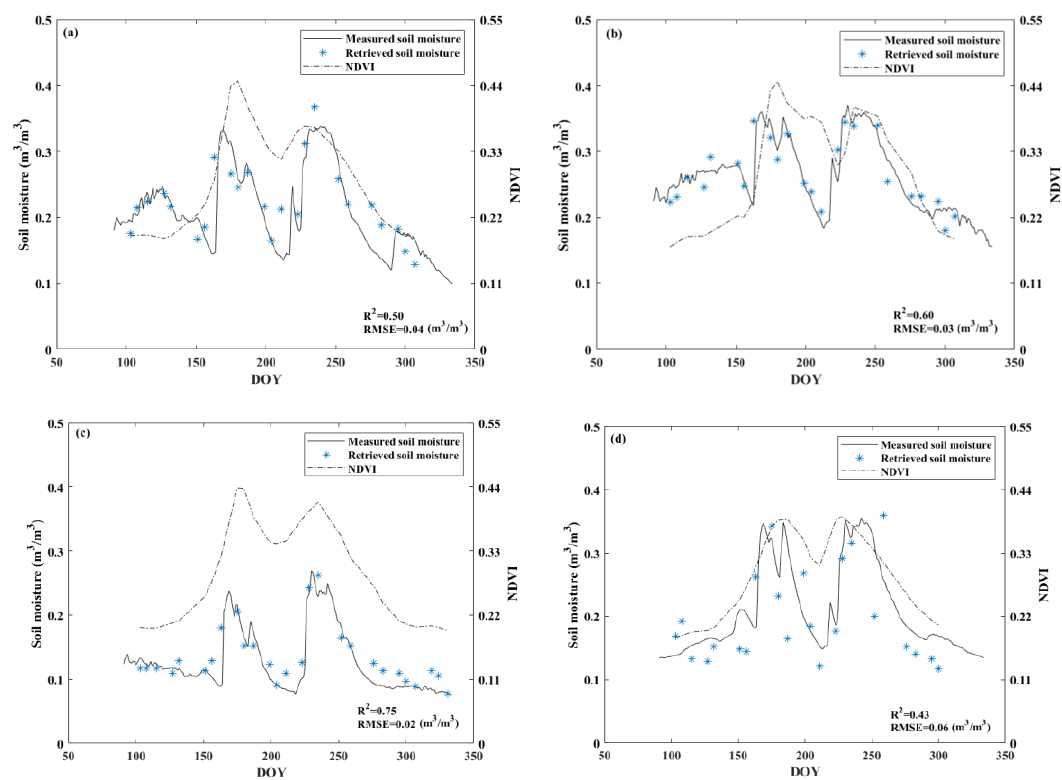
Figure 11. Time series of measured and retrieved soil moisture, with respect to NDVI over four stations ( a ) L04-M02, ( b ) L05-M06, ( c ) L07-M13, ( d ) M05.